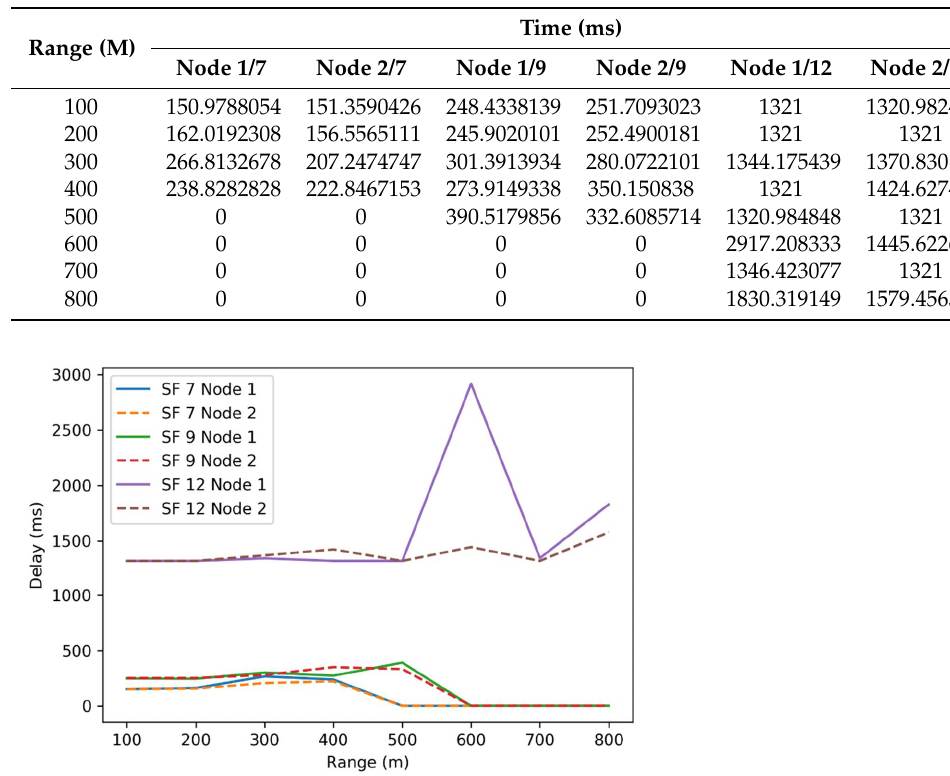
Table 3. Assessment of several spreading factor parameters.